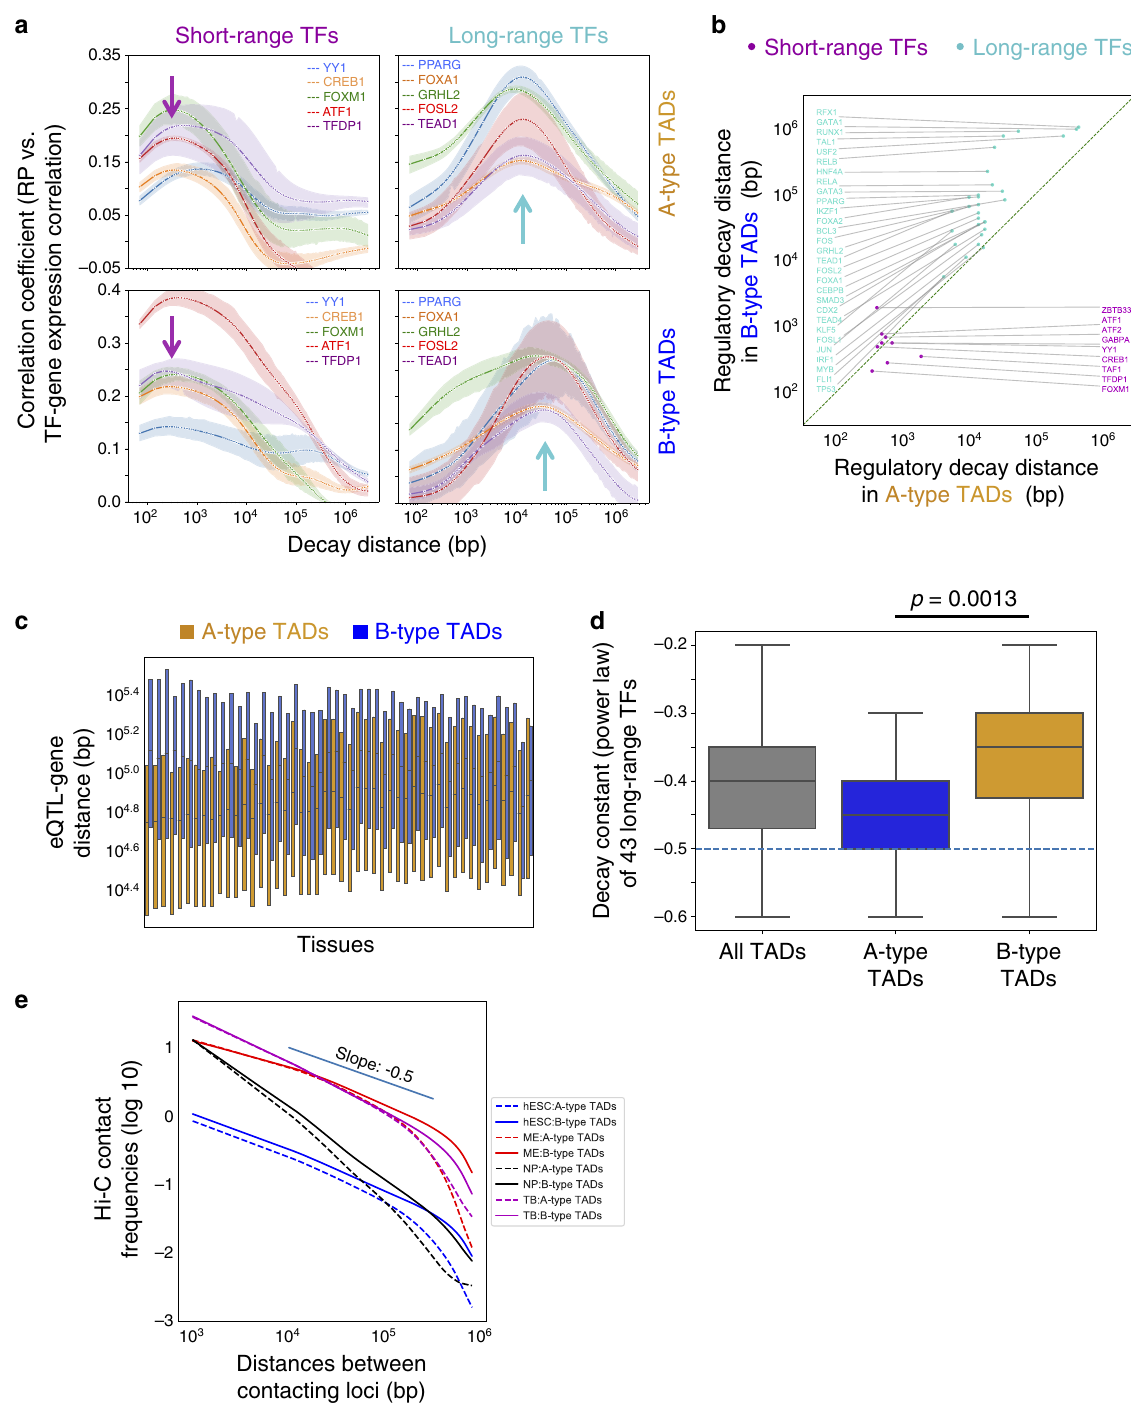
Fig. 4 Long-range TFs have longer regulatory decay distances in B-type TADs. a – b Long-range TFs have longer regulatory decay distances in B-type TADs than in A-type TADs. c In 47 (out of 48) GTEx tissues, eQTL-TSS distances are longer in B-type (blue) TADs than those in A-type (red) TADs. Tissues were sorted using differential eQTL-TSS distances between A-type and B-type TADs. The box plot extends from the lower to the upper quartile values of the data, with a line at the median. d The power-law decay rates of 49 long-range TFs measured in A-type TADs ( − 0.4 ~ − 0.5) are signi fi cantly larger (in terms of absolute magnitude) than those measured in B-type TADs ( − 0.3 ~ − 0.45), (two-sided Student ’ s t test p value = 0.0013). The box plot extends from the lower to the upper quartile values of the data, with a line at the median. The whiskers extend from the box to show the range of the data. e In human embryonic stem cells (hESC), mesendoderm (ME), neural progenitor (NP), and trophoblast-like (TB) Hi-C data, the average contact frequency between two loci decreases as the distances between the loci increases, following a power-law relationship. In the range of TAD sizes (median size 680 kb), the decay rates are more negative than − 0.5. Source data are provided as a Source Data fi